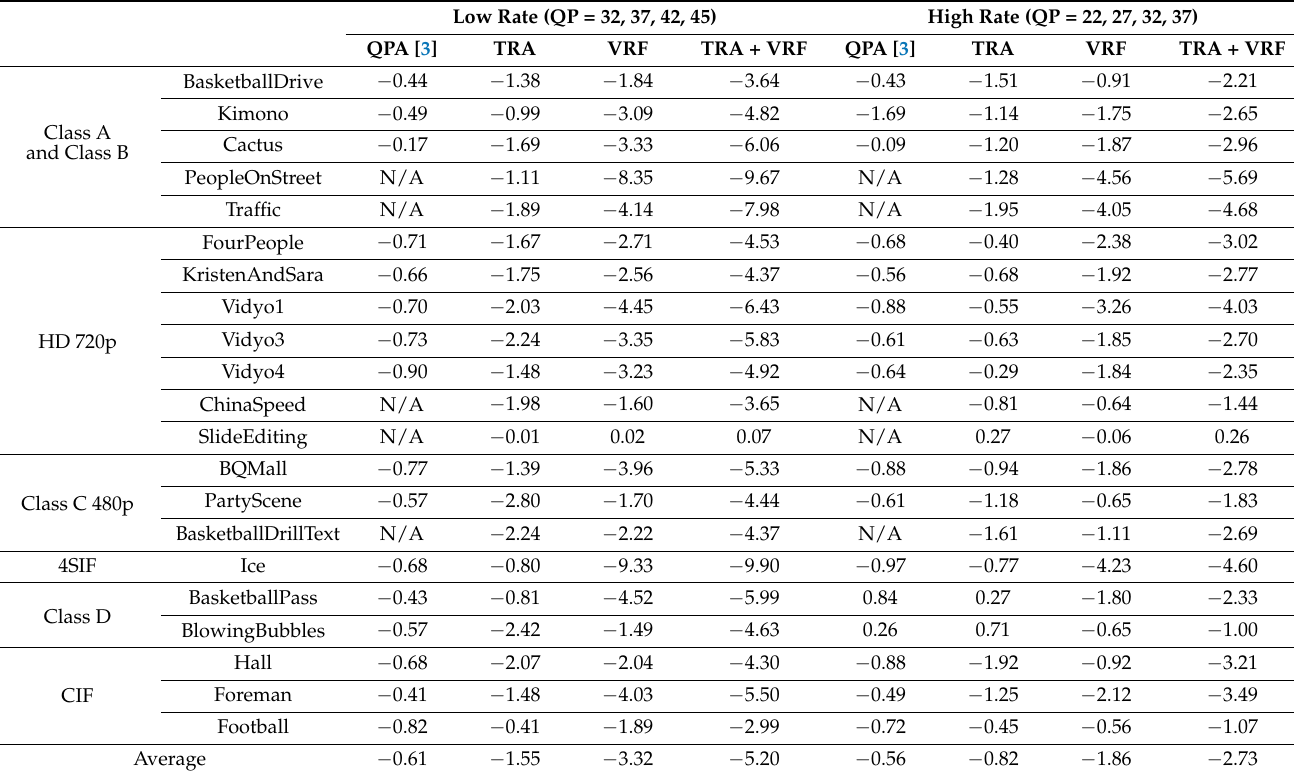
Table 3. Y-BDBR (%) coding performance of various methods for test sequences, full